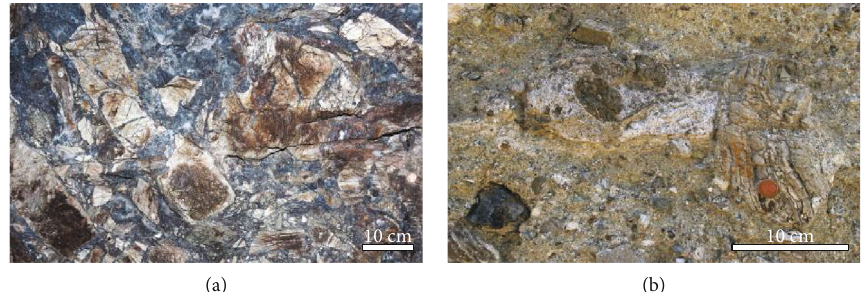
Figure 1: Examples of hydrothermal breccias. (a) Teufelsgrund mine, Black Forest, Germany (47 ° 50 ′ 37 ″ N, 7 ° 49 ′ 14 ″ E). Breccia clasts consist of local but altered host rock. The matrix mostly consists of fl uorite and barite. (b) Hidden Valley, Mt. Painter inlier, Northern Flinders Ranges, South Australia (30 ° 05 ′ 25 ″ S, 139 ° 30 ′ 28 ″ E). Clasts are a mix of various, heavily altered lithologies, such as metasediments (layered clast on right), basalts (dark clast bottom left), and basement